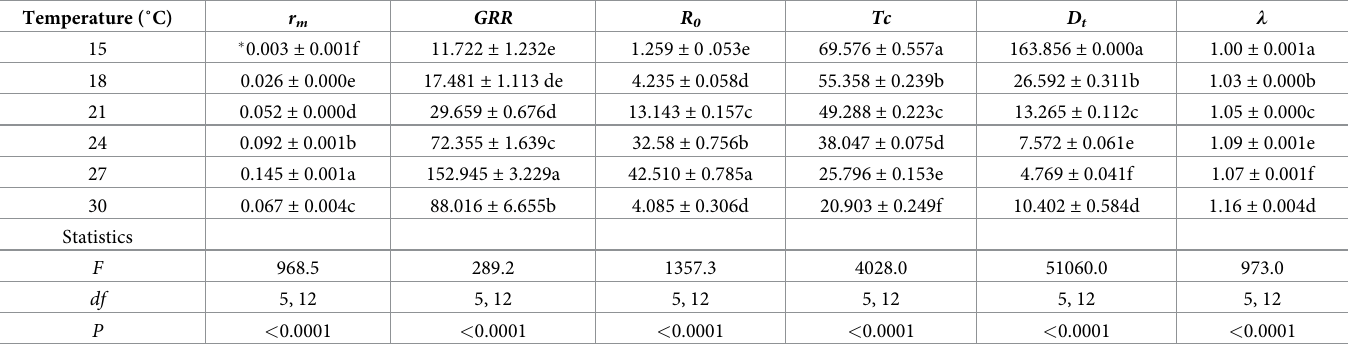
Table 5. Simulated life table parameters (mean ± SE) of Diachasmimorpha longicaudata at different constant temperatures (number of eggs used for the simula- tion = 200). r m : intrinsic rate of natural increase, GRR : gross reproduction rate, R 0 : net reproduction rate, Tc : mean generation time (in days), D t : doubling time (in days), and λ : finite rate of